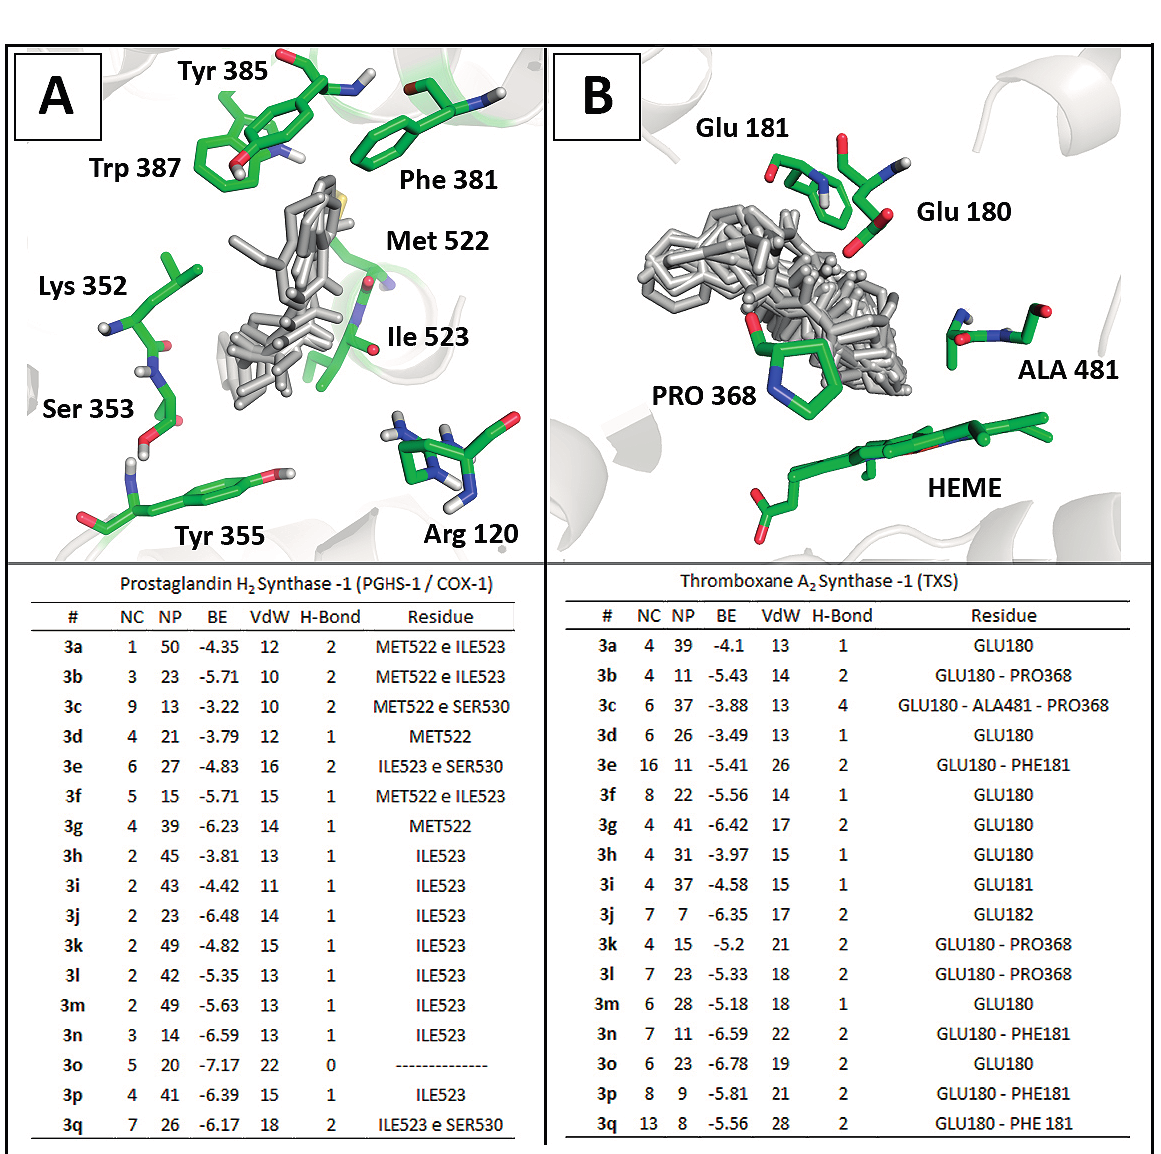
Figure 4. Comparison of molecular docking complexes of N,N' -disubstituted thioureas with ( A ) the crystallographic structure of ovine COX-1 (PDB ID: 2OYE) and ( B ) a three-dimensional model of human thromboxane synthase [29]. Interaction panels include number of clusters (NC), number of poses in the lowest energy cluster (NP), binding energy score (BE) and intermolecular interactions: Van der Waals (VdW) and hydrogen bonds